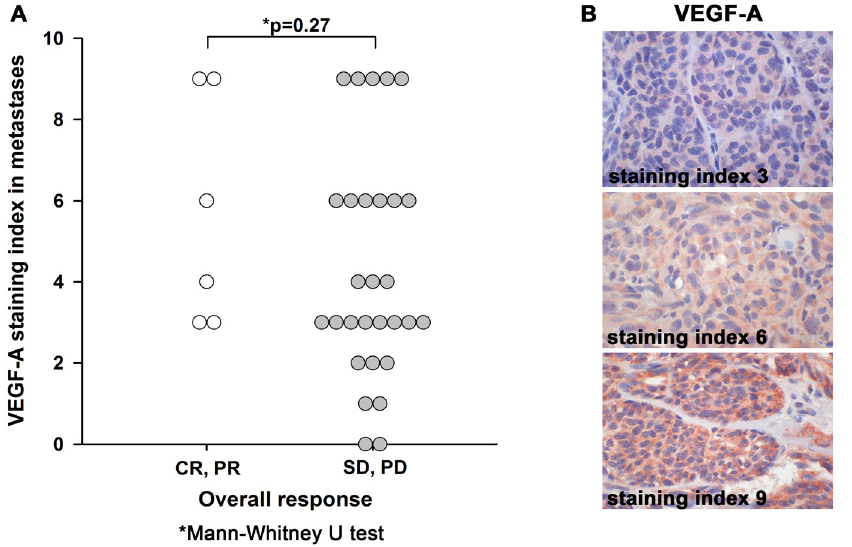
Fig 2. VEGF-A expression in metastases is not associated with overall response to bevacizumab. (A) VEGF-A expression in metastases grouped by treatment response. CR: complete clinical response, PR: partial response, SD: stable disease, PD: progressive disease. (B) Examples for low, moderate and high staining index for VEGF-A. Original magnification x630.